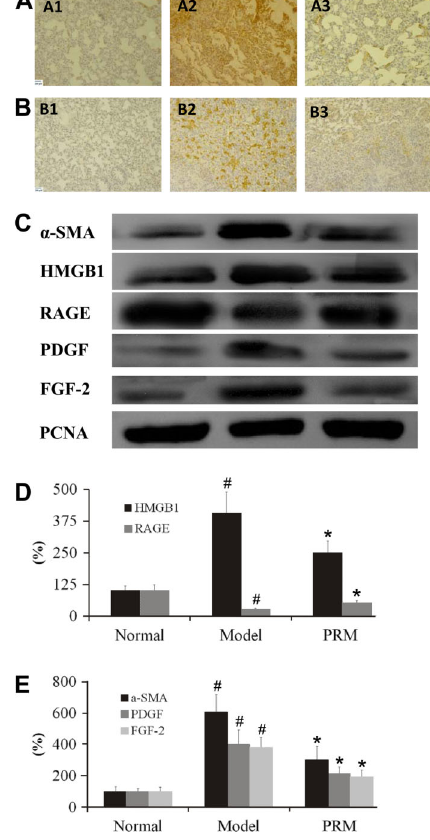
Figure 6. Effects of pulmonary rehabilitation mixture (PRM) on a - smooth muscle actin ( a -SMA), fibroblast growth factor (FGF)-2, platelet-derivedgrowthfactor(PDGF), highmobilitygroupproteinB1 (HMGB1), and receptor for advanced glycation end-product (RAGE) expressioninbleomycin(BLM)-treatedanimals.Represen- tative light microscopic appearance of a -SMA and HMGB1 in lung tissue(immunostaining)for thenormal ( A1 , B1 ),themodel ( A2 , B2 ), and 3 g/kg PRM ( A3 , B3 ). C , Representative Western blots of a - SMA, FGF-2, PDGF, HMGB1 and RAGE. D , E , Effects of PRM on a -SMA, FGF-2, PDGF, HMGB1 and RAGE expression in BLM- treated lung by Western analysis. Data are reported as means±SD. PCNA: proliferating cell nuclear antigen. # P , 0.01 vs the normal group; *P , 0.01 vs the model group (one-way ANOVA followed by Dunnett’s